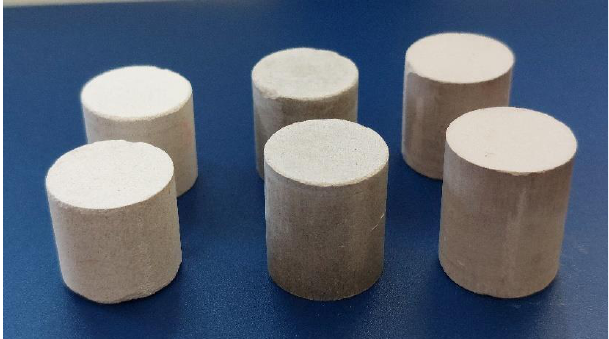
Figure 3. Prepared cylindrical compacts of LFA ( left ), WA ( middle ), and OSA ( right ). The physically bound water (moisture content) after overnight hydration (24 h) was measured to be 10 ± 1% for all samples before compaction, which was found to be a critical parameter for optimum compaction (without having any cracks due to dryness or erosion on the surfaces due to excessive water) based on previous experiences [20]. As press moulding of compacts was carried out with manual hand operated hydraulic press, seri- ous attention has been given to the uniform preparation of samples. Two different com- paction pressures (150 ± 10 and 300 ± 10 kgf/cm 2 ) were applied to investigate the effect of compaction pressure. Carbonation experiments were performed in an automated carbon- ation unit (Figure 4) (stainless-steel 400 mL jacketed pressure vessel), consisting of appa- ratus controlling temperature (Circulator C ‐ 400) and monitoring CO 2 gas consumption (Buchi pressflow gas controller (bpc)).